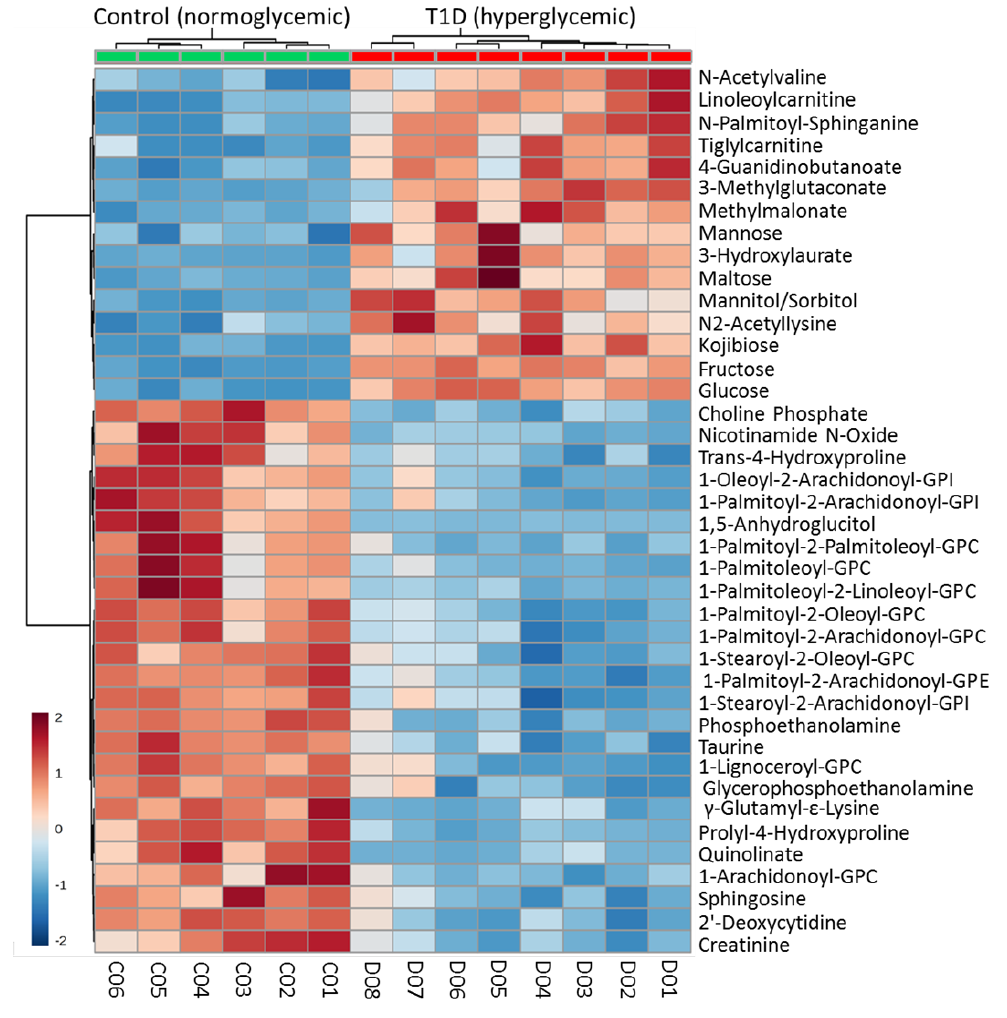
Figure 5. Heatmap analysis highlighting metabolites showing the largest change in plasma between T1D progressor ( n = 8 mice, 4F + 4M) and non-progressor (control; n = 6, 3F + 3M) NOD mice at 26 weeks of age. All progressors were diabetic at the time of this analysis; the duration of diabetes was 5–14 weeks – see Figure S2A for the corresponding rates of onset).